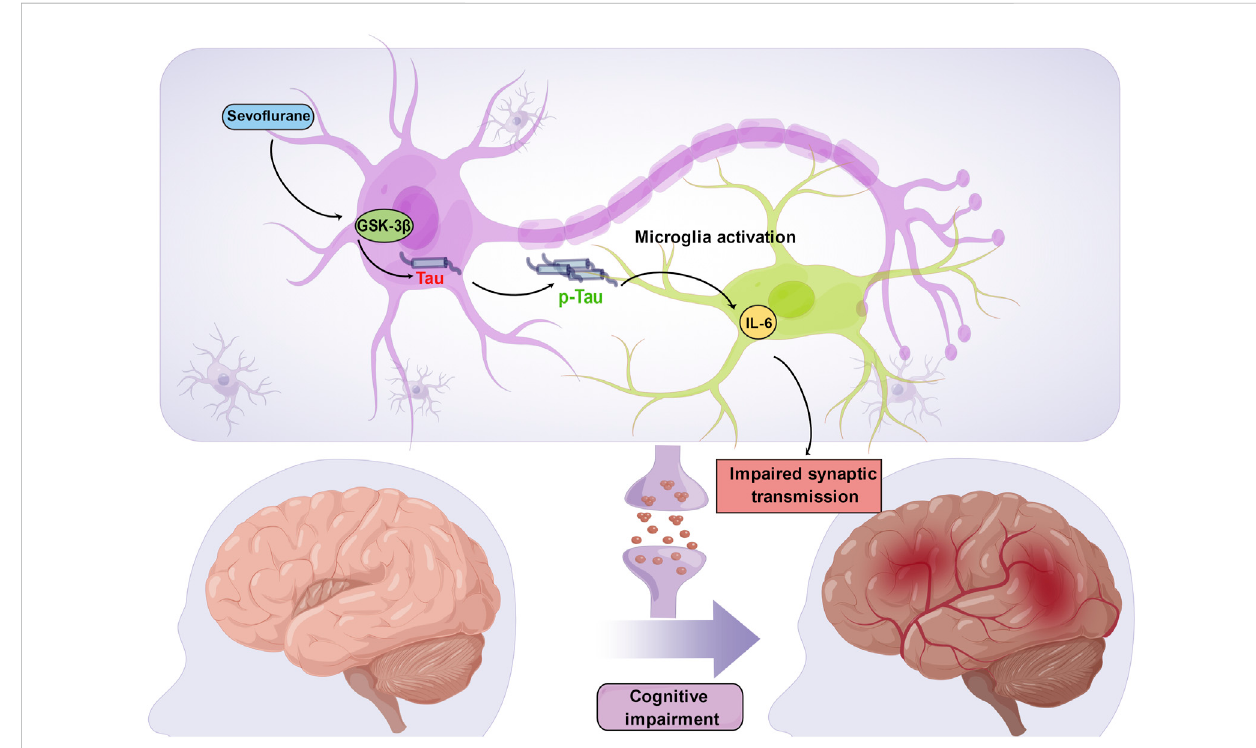
FIGURE 2 Sevo fl urane induces Tau phosphorylation in the developing brain. Sevo fl urane increases Tau phosphorylation via GSK-3 β activation, which induces extracellular vesicle-associated traf fi cking of hyperphosphorylated Tau from neurons to microglia, triggers microglial activation and produces a large amount of IL-6. High levels of hippocampal IL-6 compromise synaptic transmission and further lead to cognitive